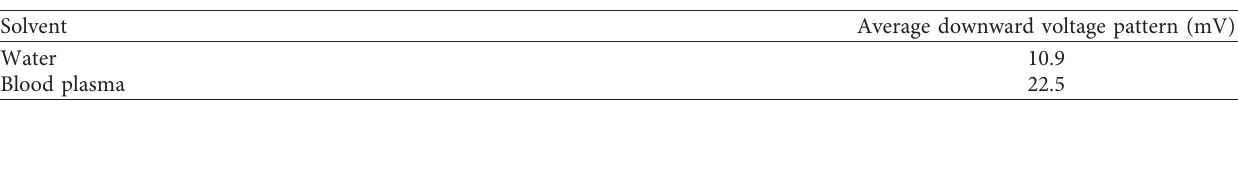
Table 6: Comparison of the average downward voltage pattern between water and plasma.